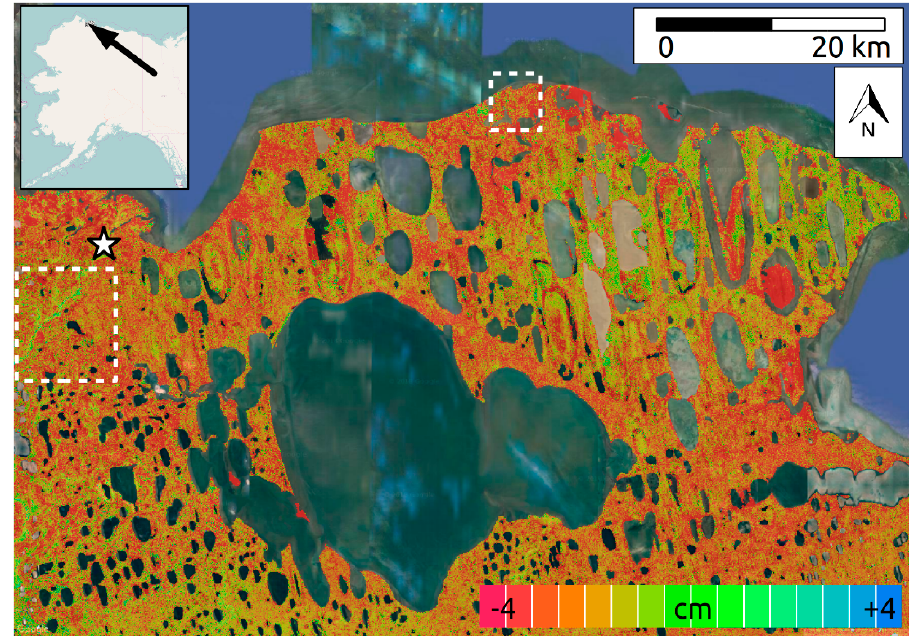
Figure 2. Subsidence map over Teshekpuk Lake (Alaska) from Sentinel ‐ 1 InSAR from 14 June to 12 October 2017. The white star indicates the reference position, the white boxes the enlargements of Figures 3 and 4.